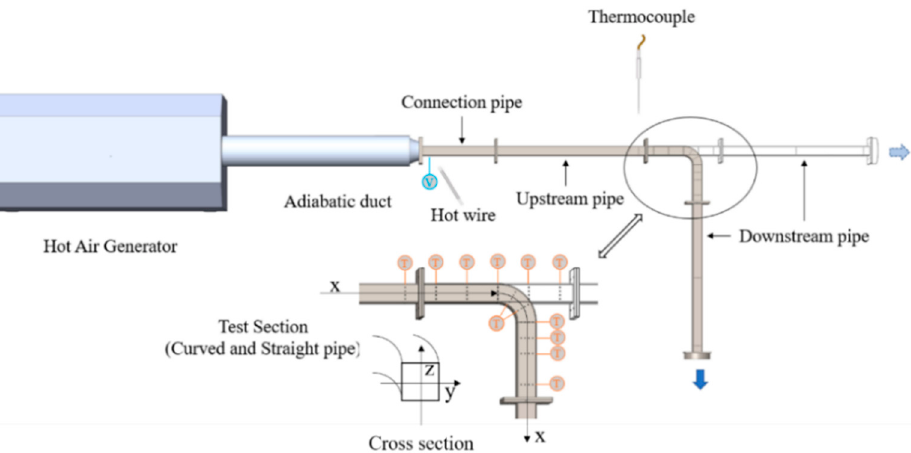
Figure 1. Schematic diagram of experimental apparatus and coordinate system.